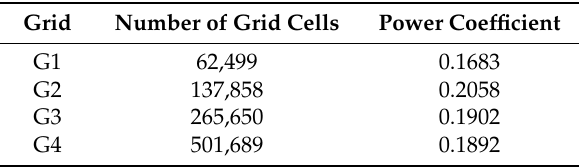
Table 1. Comparison of mesh refinements in power coefficient of a VAWT rotating with an angular velocity of 2π rad/s in 10 m/s ambient wind.